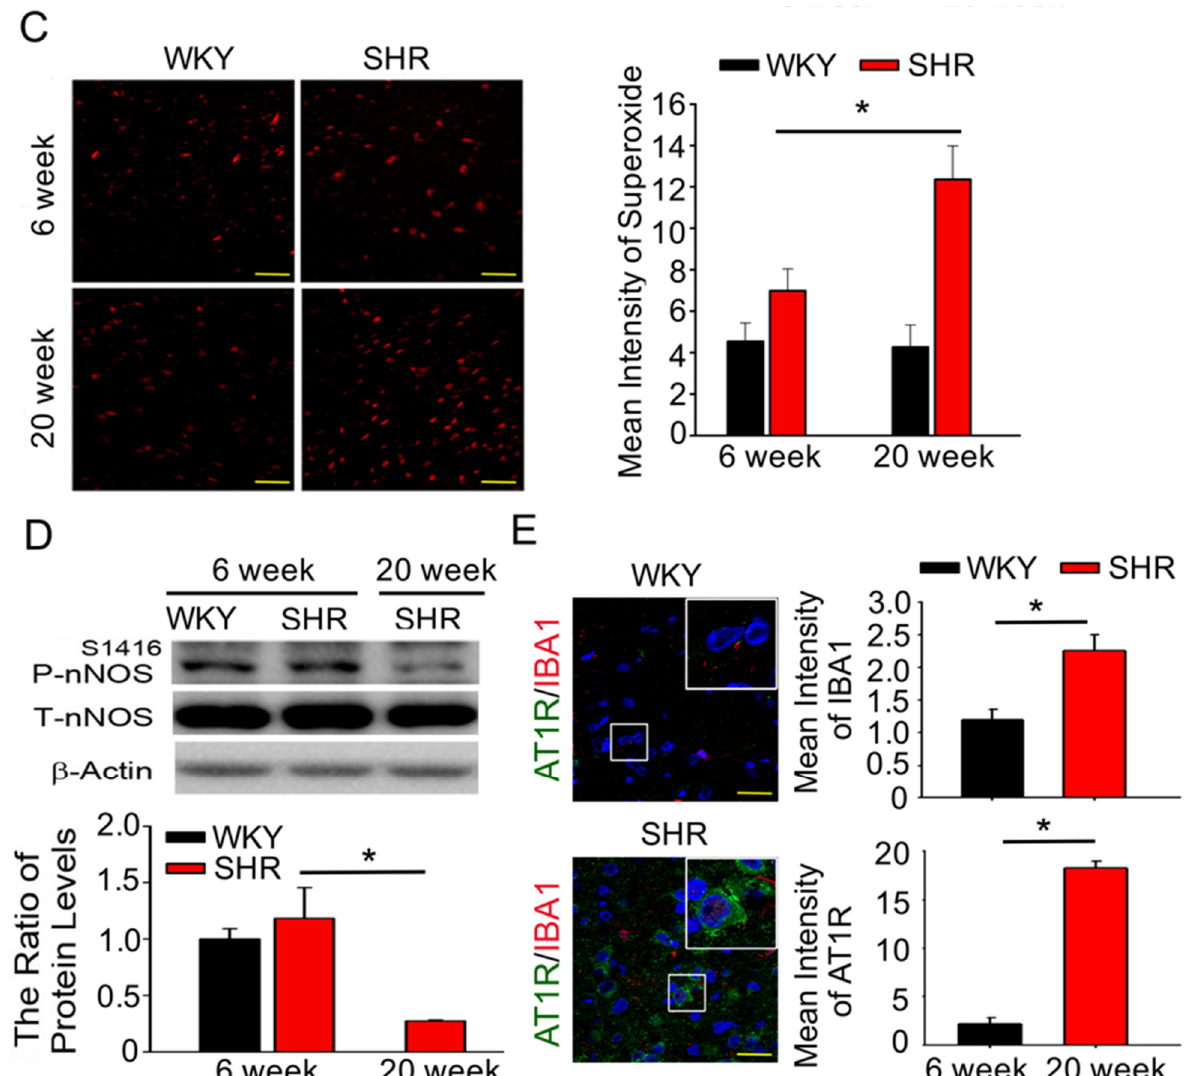
Figure 1. Ang II supports superoxide generation, increases the activation of microglia and restores the nNOS pathway in the NTS of spontaneously hypertensive rats. ( A , B ) Graph showing systemic blood pressure (SBP) and nitric oxide (NO) concentrations in the nucleus tractus solitarius (NTS) of normotensive Wistar Kyoto rats (WKY; 6-, 20-week-old) and spontaneously hypertensive rats (SHRs; 6-, 20-week-old). The bar graph shows the NO concentration as µ M nitrate per µ g of total protein. ( C ) Representative images of DHE-treated brain sections, images photographed at × 280 magnification. ROS index in the NTS of the SHRs groups (20 weeks old) was compared to SHRs (6 weeks old). The ROS index is the relative mean fluorescence intensity for dihydroethidium. Sections including the NTS of SHRs rats displayed significant increase in DHE fluorescence compared with the SHRs (6 weeks old) group sections. ( D ) Quantitative immunoblotting analysis of nNOS S1416 phosphorylation in the NTS of 6-week-old WKY, SHRs and 20-week-old SHRs. One-way analysis of variance (ANOVA) with Scheff é post-hoc was performed for statistical analysis in Figure 1A–D. ( E ) Representative images for immunofluorescence staining of AT1R-positive cells (green) and microglial marker IBA-1 (red) in NTS sections of WKY and SHRs, counterstained with 4 (cid:48) ,6-diamidino-2-phenylindole (DAPI for blue color). The images were photographed at × 400 and 1000 magnification. The Mann–Whitney U-test was performed for statistical analysis in Figure 1E. The values are presented as mean ± SEM. * p < 0.05 indicates significant difference from 6-week-old SHRs ( n = 6~8 per